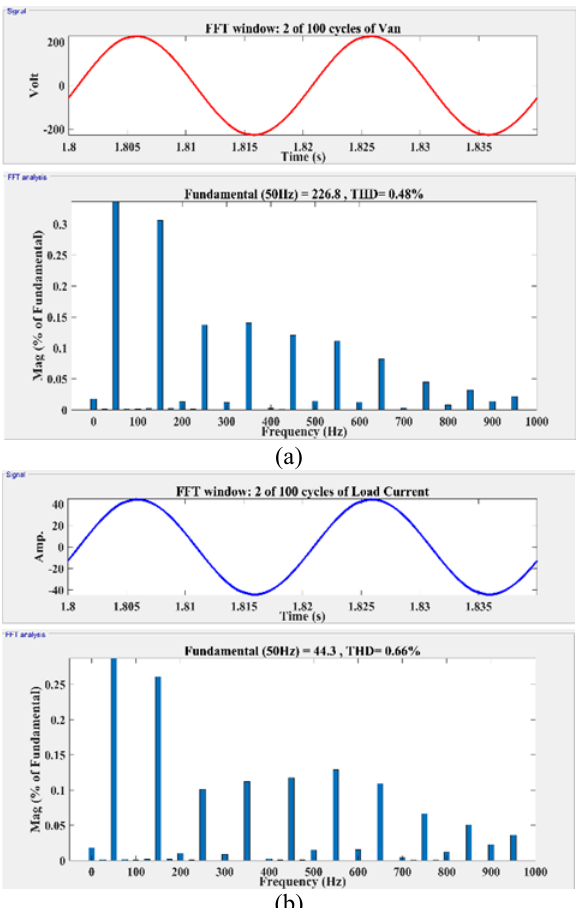
Fig.7. Total Harmonic Distortion of the voltage and current with PD_PWM: (a) THD for phase voltage, (b) THD for line